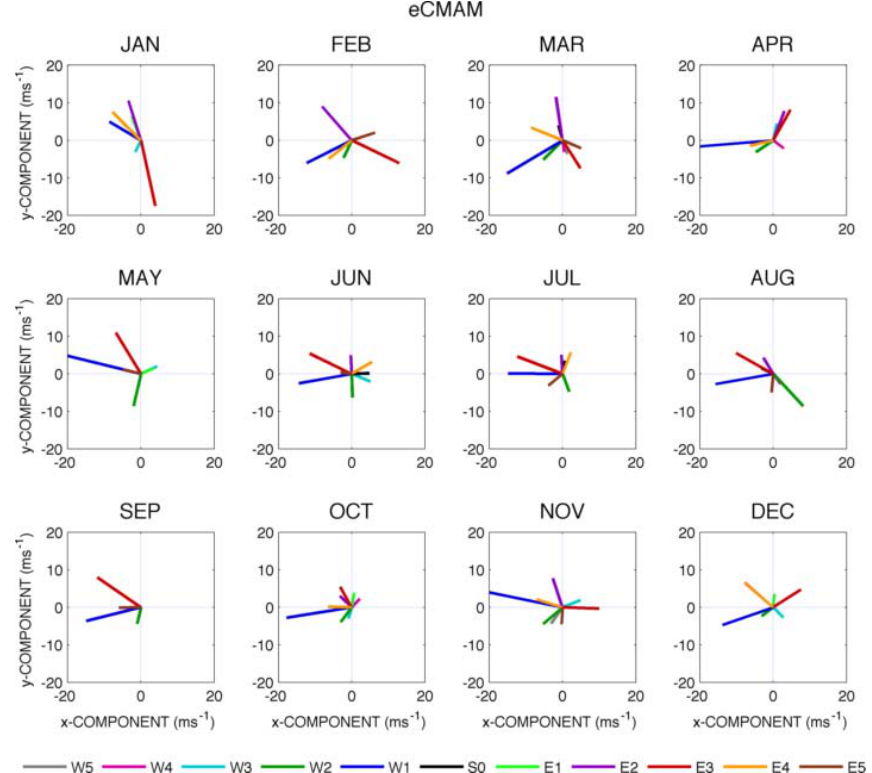
Fig. 18. Phasor plots of the individual wavenumbers contributing to the eCMAM-predicted zonal diurnal tide at a height of 90km. The length of each component represents the magnitude of its contribution, and the angle as measured anticlockwise from the positive x axis gives the phase. Only those components with magnitude greater than 3ms − 1 are